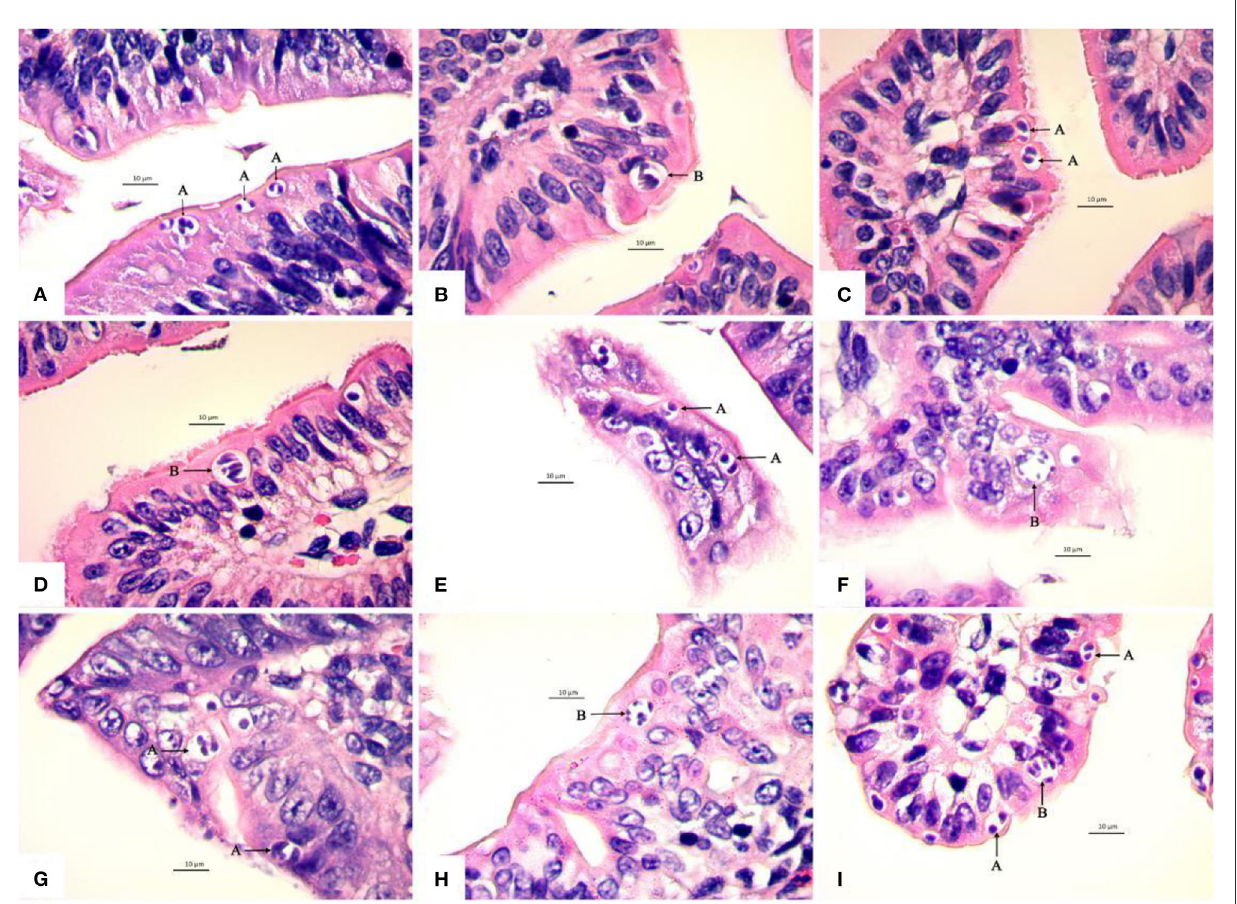
FIGURE3 Light micrographs showing four schizogonies of E. kongi in the jejunum and ileum of experimentally infected rabbits ( × 1,000). Scale bar = 10 µ m. (A) The type A schizonts (A) of the first generation at 72h p.i. (B) The type B schizont (B) of the first generation at 72h p.i. (C) The type A schizonts (A) of the second generation at 84h p.i. (D) The type B schizont (B) of the second generation at 84h p.i. (E) The type A schizonts (A) of the second generation at 96h p.i. (F) The type B schizont (B) of the second generation at 96h p.i. (G) The type A schizont (A) of the third generation at 108h p.i. (H) The type B schizont (B) of the third generation at 108h p.i. (I) The type A schizonts (A) and type B schizont (B) of the fourth generation at 120h p.i.